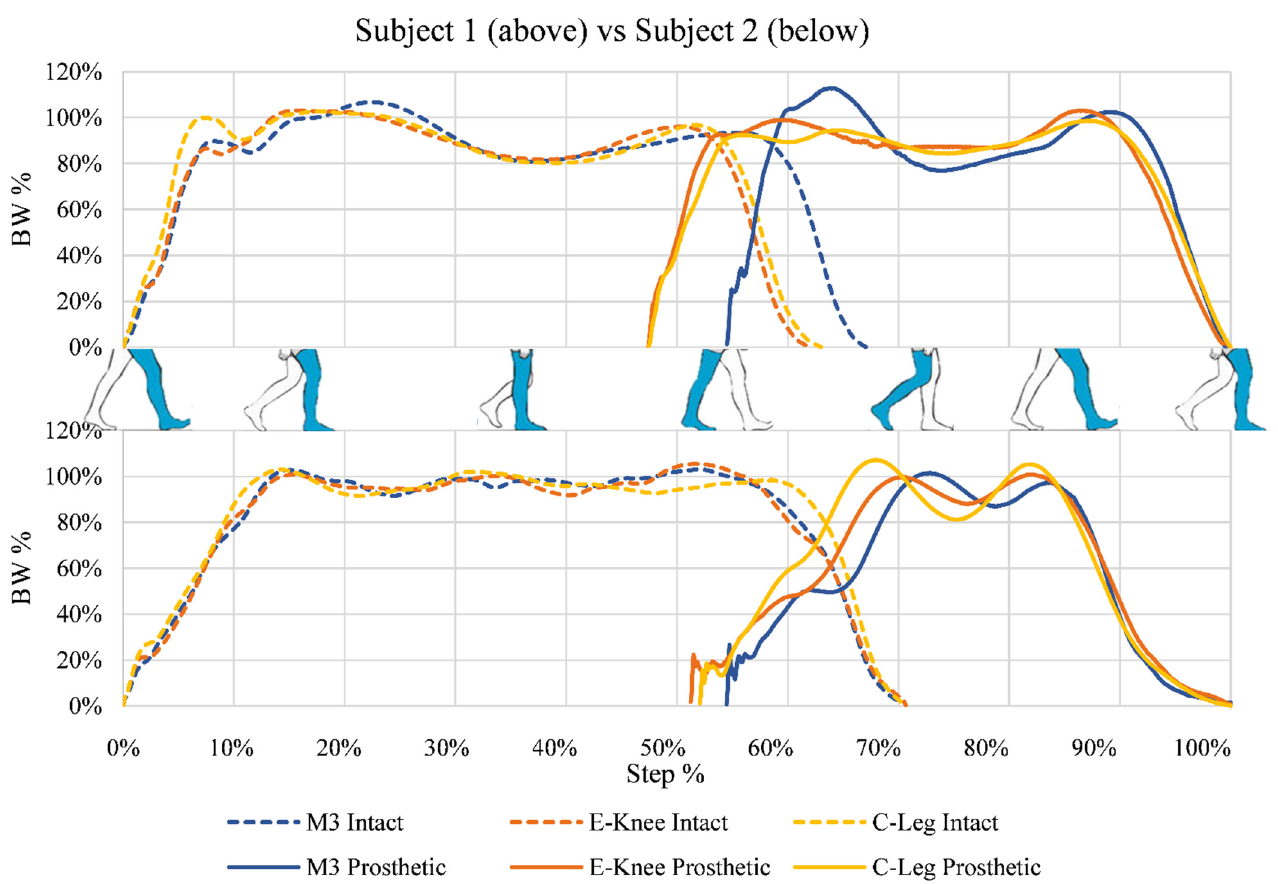
Figure 3. Subjects 1 and 2 ′ s vertical GRFs for each prosthesis in the walking trial (top and bottom). Shown in two parts: the intact stance (dashed), and the prosthetic stance (solid). Given in body weight percentage (BW %) over one step (time from intact heel strike to prosthesis toe off). Standard deviations for Subject 1 and Subject 2 within datasets averaged to 3.43% and 5.10%, respectively. Step phase figures adapted from Pirker et al. [32].